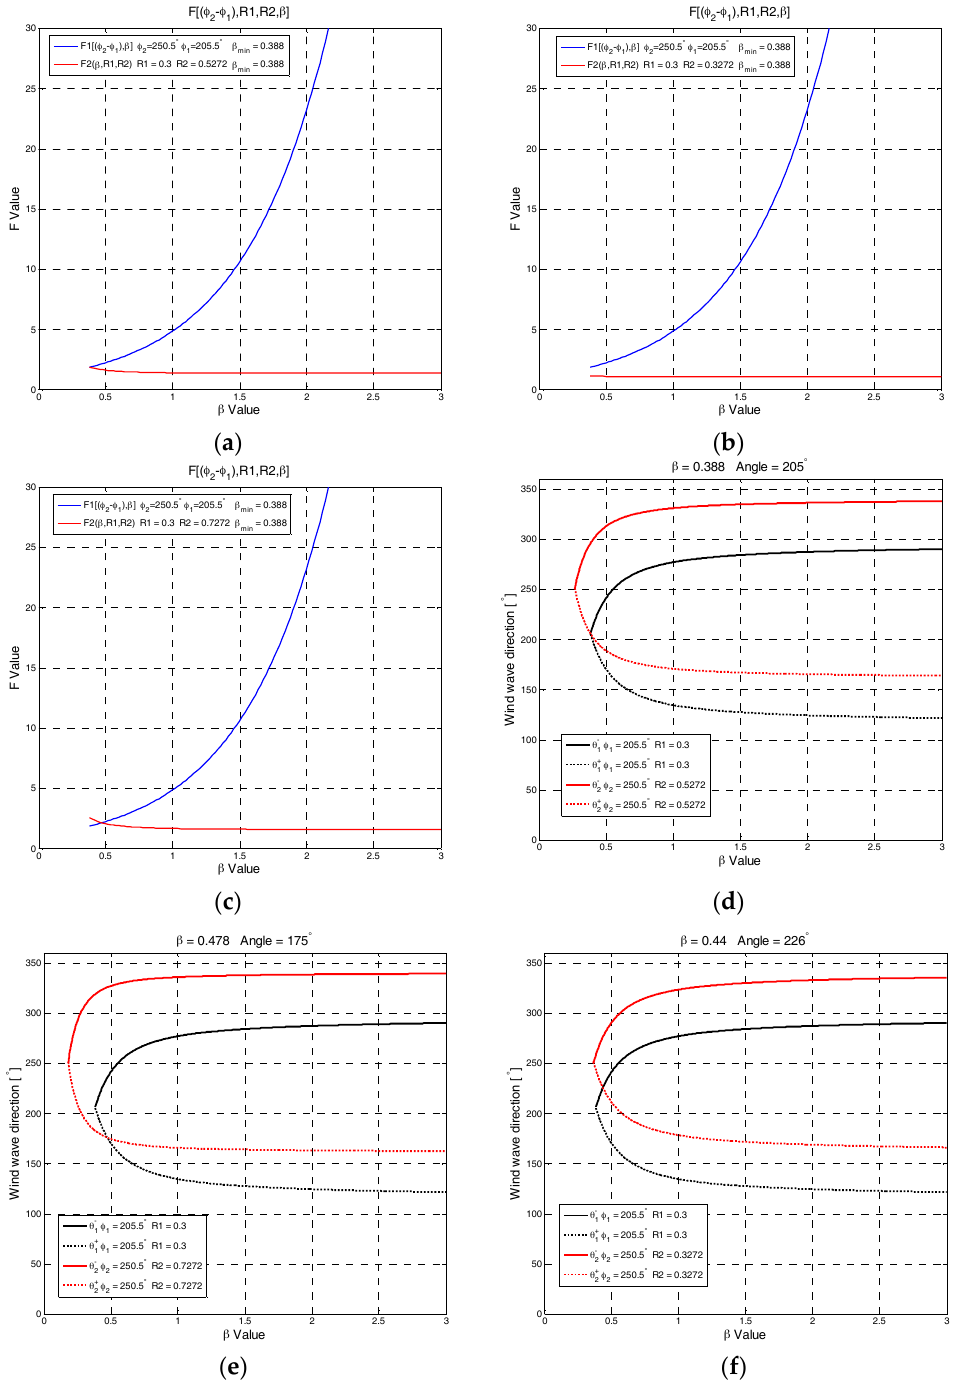
Figure 4. The threshold for R 2 having a cross-point for the curves 𝜃 (cid:2869)(cid:2878) and 𝜃 (cid:2870)(cid:2878) . ( a ) Curves of F 1 and F 2 ( R 2 = R 2,min ); ( b ) curves of F 1 and F 2 ( R 2 > R 2,min ); ( c ) curves of F 1 and F 2 ( R 2 < R 2,min ); ( d ) curves of 𝜃 (cid:2869)± and 𝜃 (cid:2870)± ( R 2 = R 2,min ); ( e ) curves of 𝜃 (cid:2869)± and 𝜃 (cid:2870)± ( R 2 > R 2,min ); and ( f ) curves of 𝜃 (cid:2869)± and 𝜃 (cid:2870)± ( R 2 < R 2,min ).